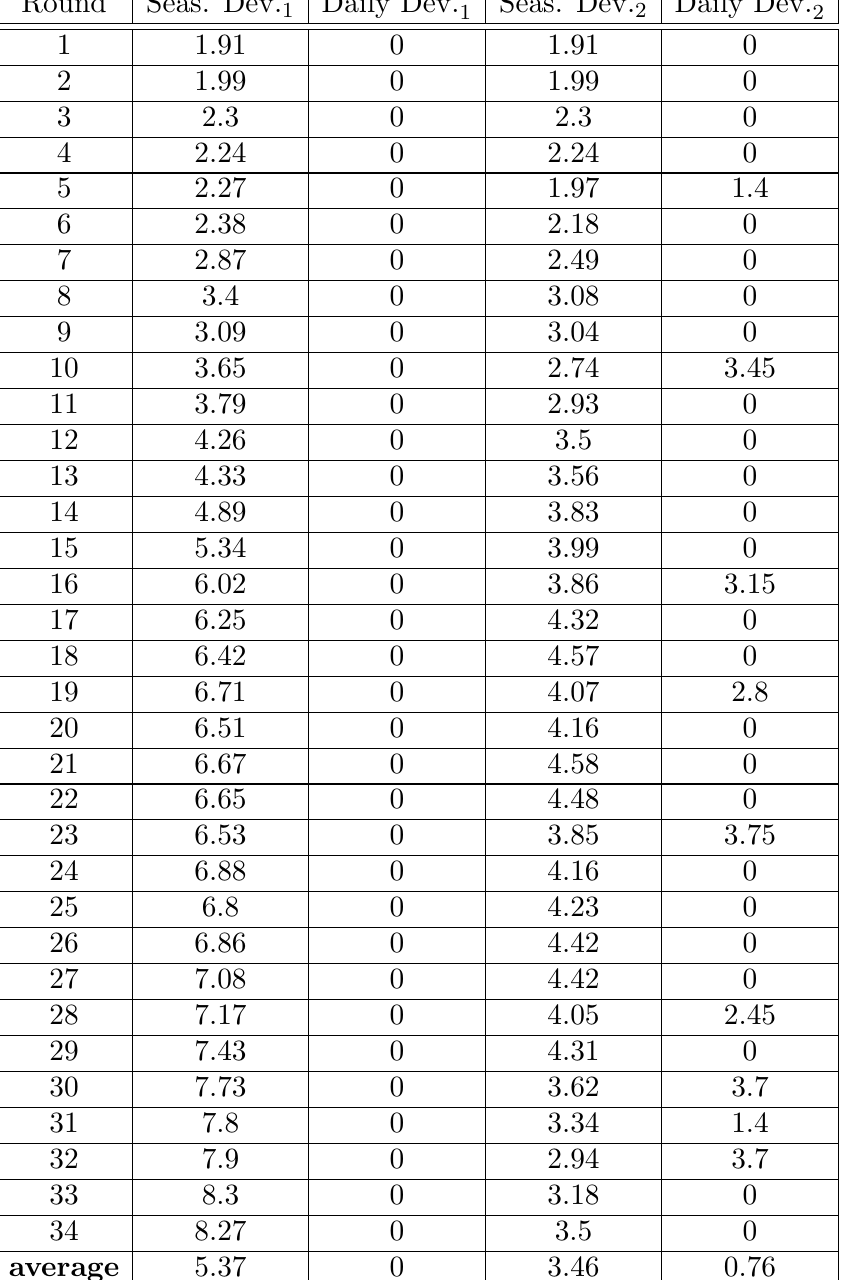
Table 11. The objective function values obtained by the optimal schedules (for the baseline case and the c 2 = 0 . 2 case, indexed as 1 and 2,